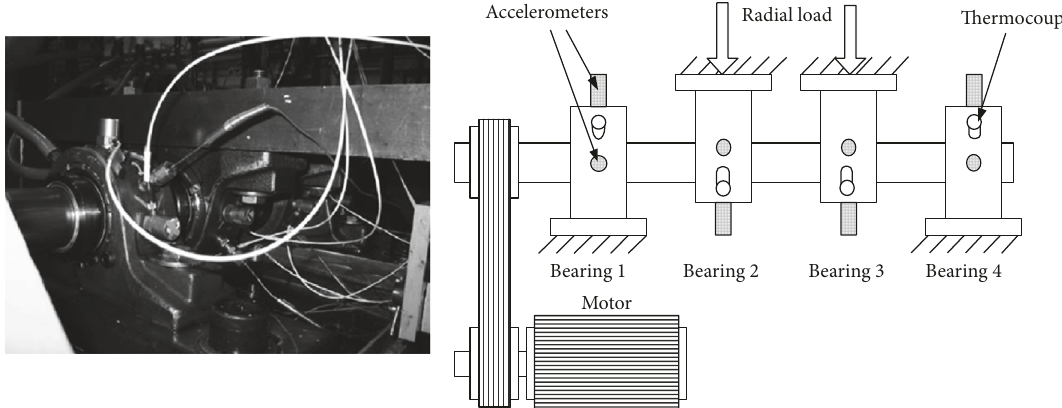
Figure 7: Bearing test rig and sensor placement illustration.